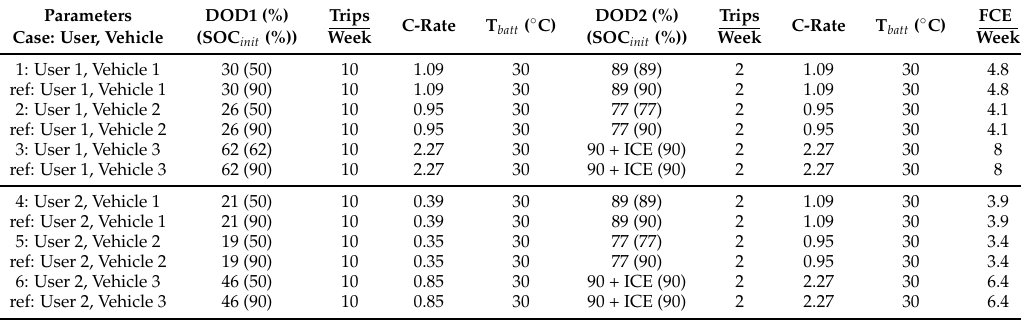
Table 6. Drive cases translated into DOD, inital State of Charge (SOC init ), C-rate, and Full Cycle Equivialent (FCE) per week to be used as ageing model input values. Parameters DOD1 (%)